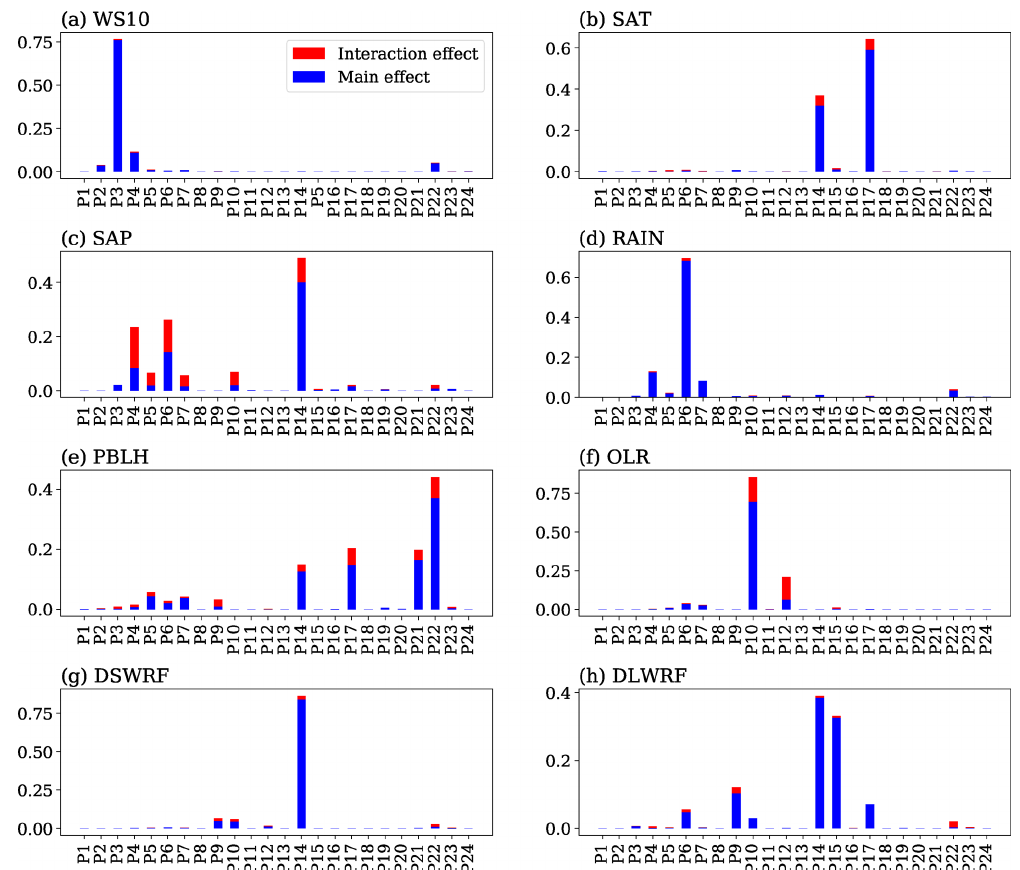
Figure 11. Sobol’s primary and secondary effects of 24 parameters for the meteorological variables considered.